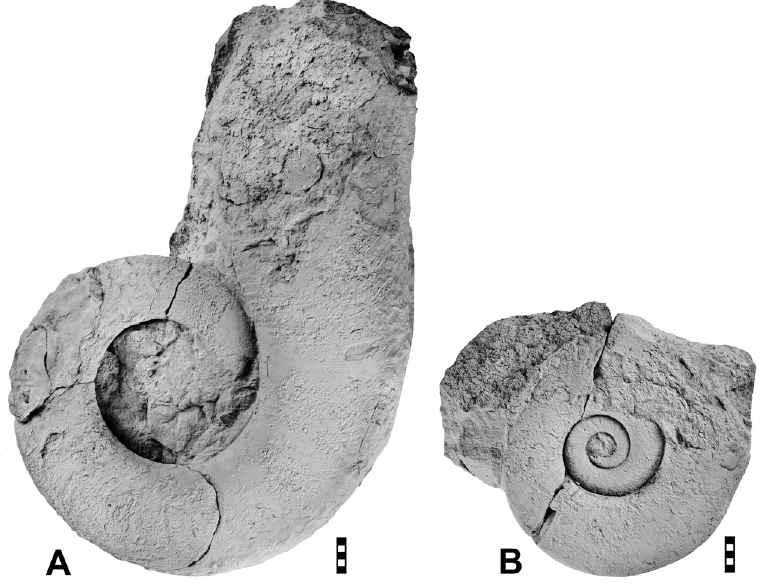
Fig. 28. Angelinoceras Hyatt, 1894 from the Upper Red Orthoceratite Limestone. A . Angelinoceras latum (Angelin, 1880), specimen MB.C.11682 (Remelé 1878 Coll.) from Eberswalde (Brandenburg); lateral view. B . Angelinoceras sp., specimen MB.C.29658 (Krueger Coll.) from Oderberg (Brandenburg). Scale bar units = 1